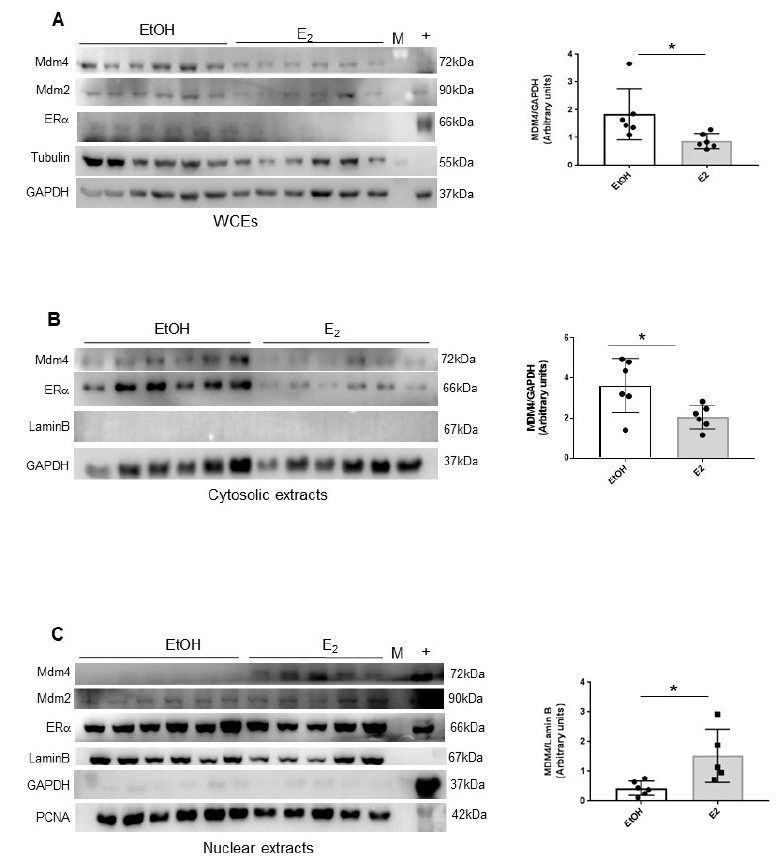
Figure 4. E 2 alters the subcellular localization of Mdm4 in mouse thymocytes. ( A – C ), WB analysis of whole cell extracts (WCEs) ( A ) cytosolic extracts ( B ) and nuclear extracts ( C ) of thymocytes of Mdm4 Tg15 females treated with a single i.p. dose of physiologic solution or 50 µ g / Kg E 2 and sacrificed after 16 h. Laminin and GAPDH were used as LC. Graphs show mean ± SD of MDM4 levels quantified by Alliance V_1607 software (two-tailed unpaired t -test, WCEs: t = 2.443, df = 10, * p = 0.0346, Cytosolic extracts: t = 2.629, df = 10, * p = 0.0252, Nuclear extracts: t = 2.891, df = 9, * p = 0,0179).